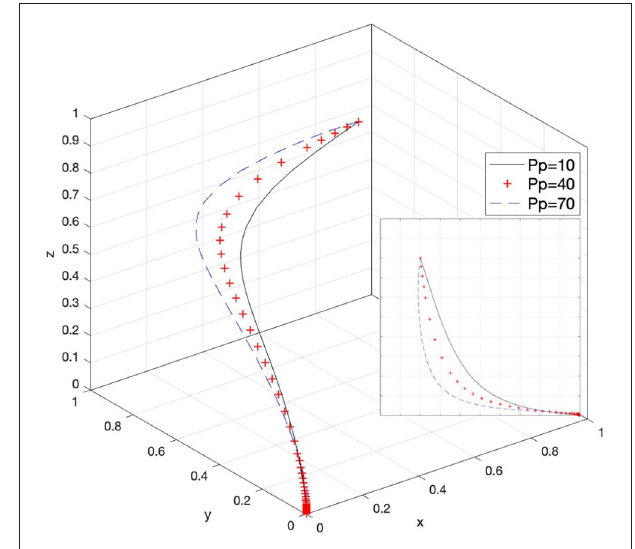
FIGURE 5 | Effect of the fines for e-commerce platforms’ passive